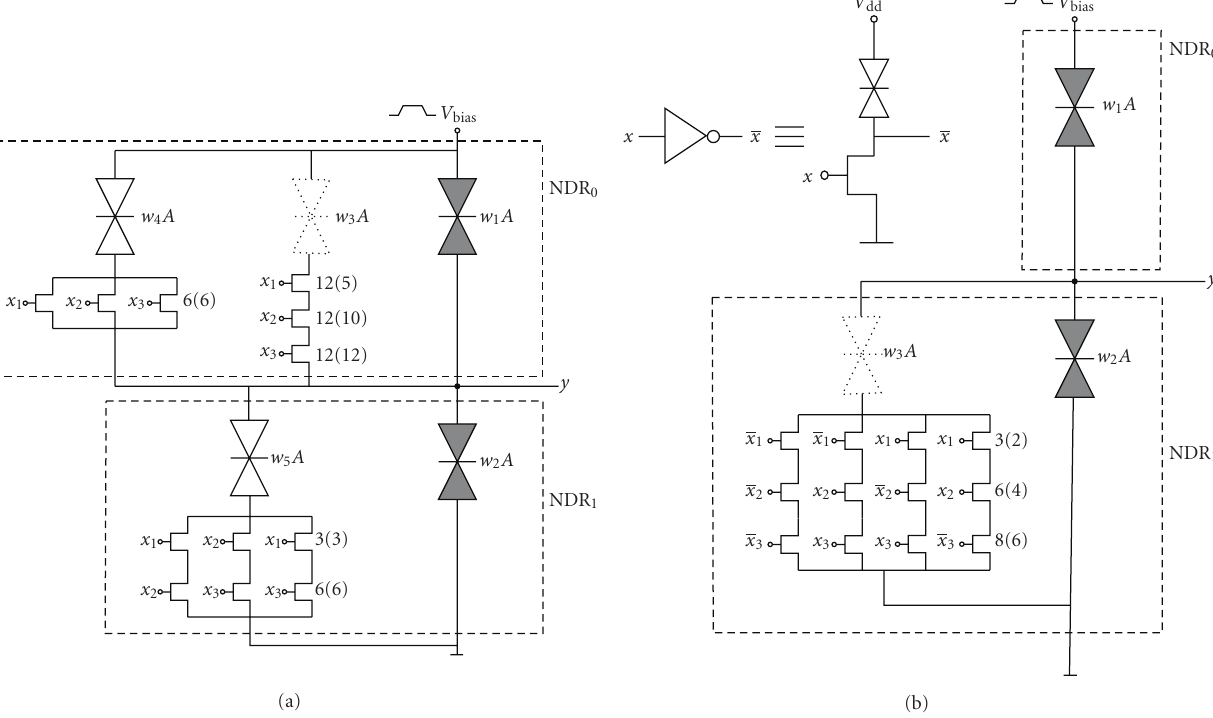
Figure 1: (a) The proposed GTG-2 three-input XOR. RTD areas are w 1 A , w 3 A , w 4 A , w 5 A = 2 μ m 2 , and w 2 A = 3 μ m 2 . After eliminating the dotted RTD (GTG-4) other RTD areas are: w 1 A , w 4 A , w 5 A = 2 μ m 2 , w 2 A = 3 μ m 2 , and w 3 A = infinity (i.e., RTD replaced with a short circuit). (b) The proposed GTG-3 three-input XOR. RTD areas are w 3 A , w 2 A = 2 μ m 2 , and w 1 A = 3 μ m 2 and after eliminating the dotted RTD (GTG-5) other RTD areas are w 3 A = infinity (i.e., RTD replaced with a short circuit), W 2 A = 2 μ m 2 , and W 1 A = 3 μ m 2 . In this figure the transistors widths are shown as well. The transistors in the same row have the same size ( μ m) and parenthesized numbers show the values for GTG-4 and GTG-5 (after replacing the RTDs with short circuits). For modeling the transistors, a 130nm HSPICE transistor model is